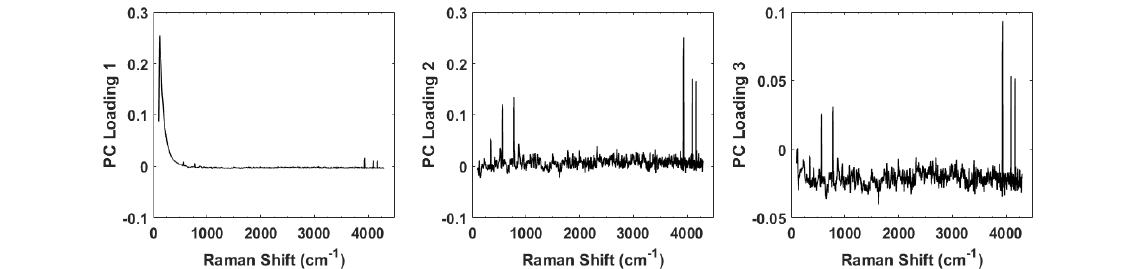
Figure 6. Plots of the loadings for the first three principal components. The loadings for the first is dominated by a large Rayleigh peak near the 0 cm − 1 shift, but small peaks can be seen further out. The loadings for the second and third principal components clearly show the peaks and contribute strongly to the discrimination capability of the spectra.